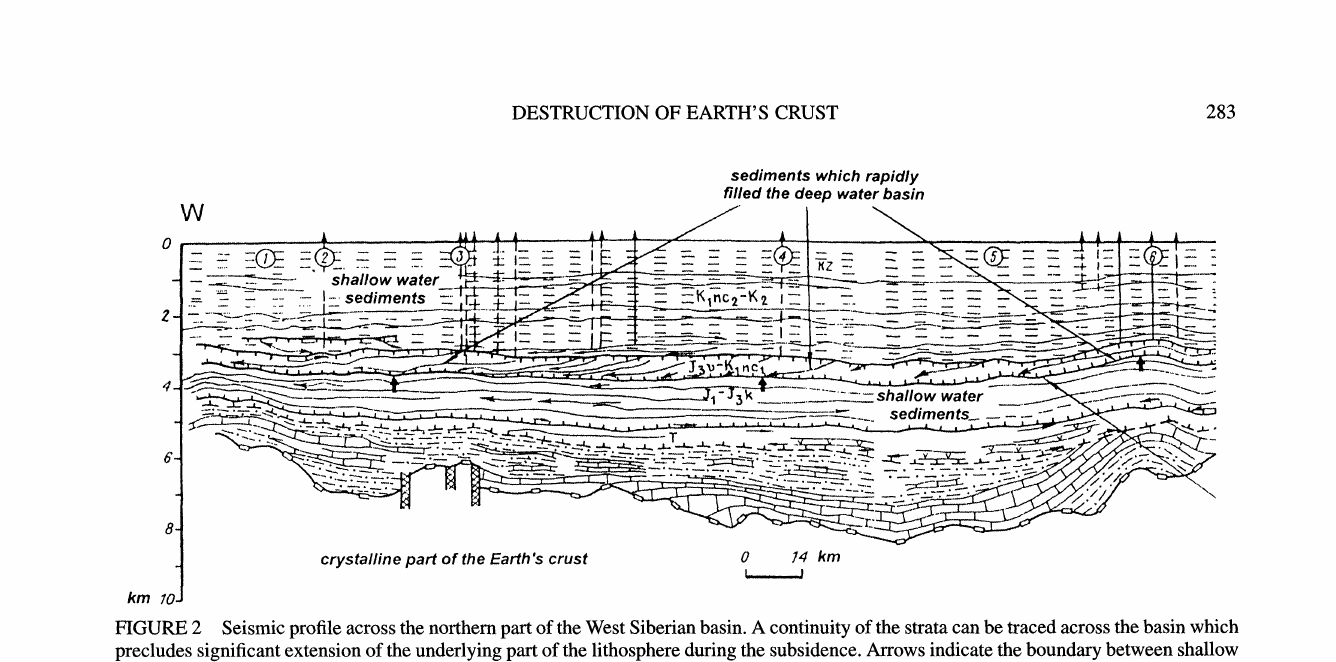
FIGURE 2 Seismic profile across the northern part of the West Siberian basin. A continuity of the strata can be traced across the basin which precludes significant extension of the underlying part ofthe lithosphere during the subsidence. Arrows indicate the boundary between shallow water deposits and deep water sediments which began to form after the rapid subsidence 150 million years